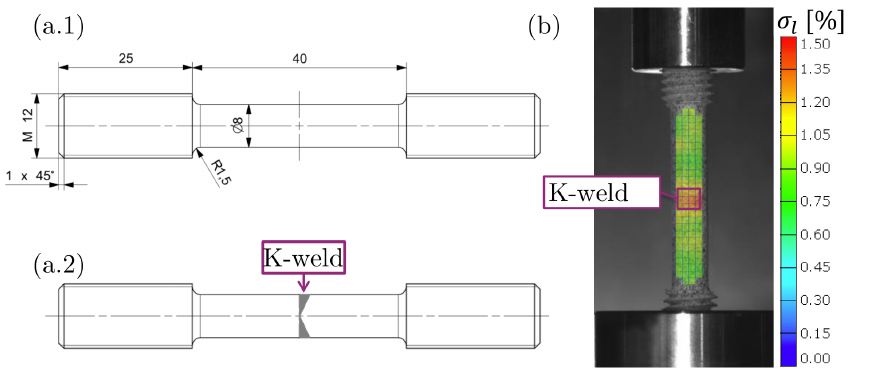
Figure 2. Drawing of laboratory specimens: without weld (a.1), with K-weld (a.2); longitudinal strain measured during testing (b).